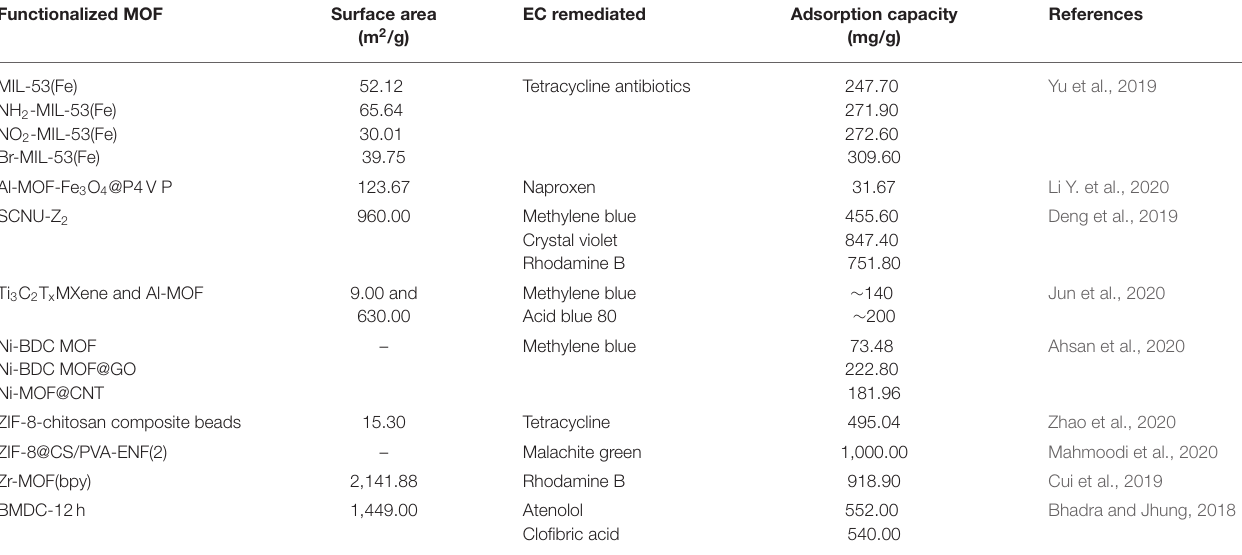
TABLE 6 | Comparison of the adsorption capacity of different types of metal organic frameworks (MOFs) for emerging contaminant (EC) remediation. Functionalized MOF